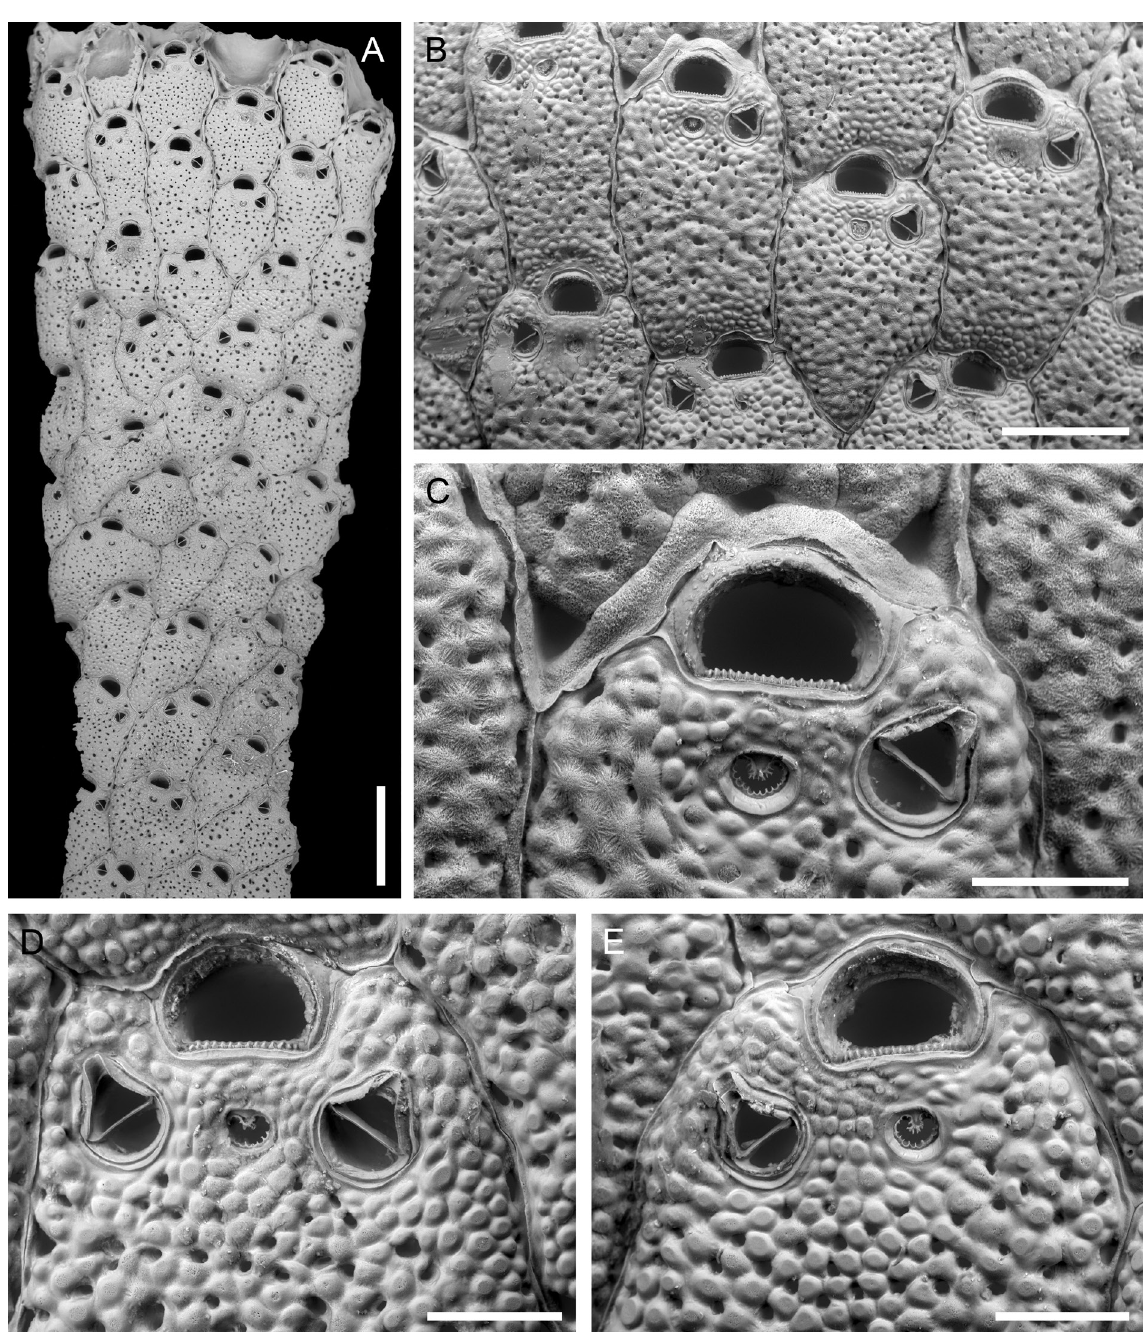
Fig. 12. Microporella sp. 1, BLEED 151, Recent, Puysegur Bank. A . General view of the branch fragment. B . Group of autozooids. C . Close-up of orifice, ascopore and avicularium. D . Close-up of an autozooid with paired avicularia. E . Close-up of an autozooid with avicularium showing intramural budding. Scale bars: A = 1 mm; B = 500 µm; C–E = 150